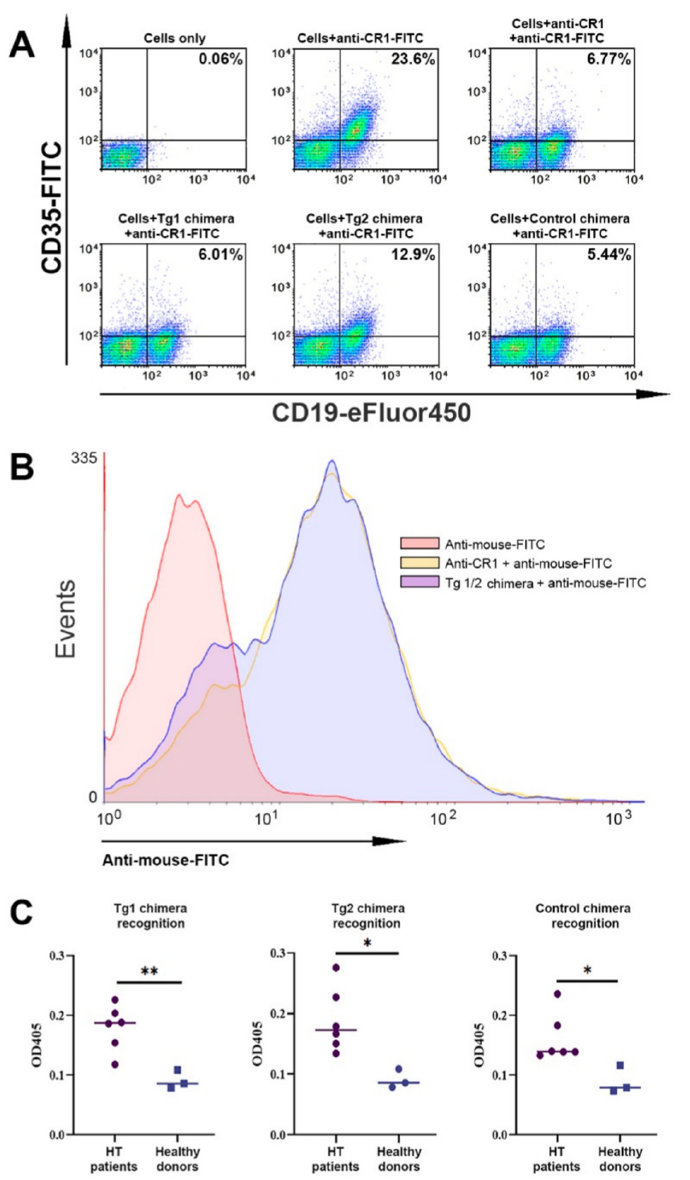
Figure 3. Tg 1/2 chimeras bind to CD35 expressed on B cells isolated from HT patients and are recognized by anti-Tg IgG antibodies. ( A ) A competition binding assay for CD35 was performed by flow cytometry. Isolated PBMCs from HT patients were incubated with the Tg1 chimera, or with the Tg2 chimera, or with the Control chimera, or with unconjugated 3D9 MoAb, or PBS alone, followed by incubation with anti-human CD19-eFlour450/CD3-PeCy7 antibodies together with FITC-conjugated anti-human CD35. ( B ) The same PBMCs were incubated with the Tg1/2 chimeras, or with unconjugated 3D9 MoAb, or with PBS alone, followed by incubation with FITC-conjugated anti-mouse IgG antibody together with CD19-eFlour450/CD3-PeCy7 antibodies. Gated CD19+ or CD3+ lymphocytes were analyzed by flow cytometry. Data are representative of at least 6 independent experiments. ( C ) The Tg1 and Tg2 epitopes retain their capability to be recognized by anti-Tg IgG antibodies. Tg 1/2 peptide recognition was performed by ELISA assay. The Tg1 chimera (left), Tg2 chimera (middle), and Control chimera (right) were loaded on the immune plate and incubated with diluted sera from HT patients or healthy subjects. All samples were triplicated and average values were used for analysis. Mean ± SD values were calculated for each group; p -values were calculated (* p < 0.05, ** p < 0.01). Data are representative of 4 independent